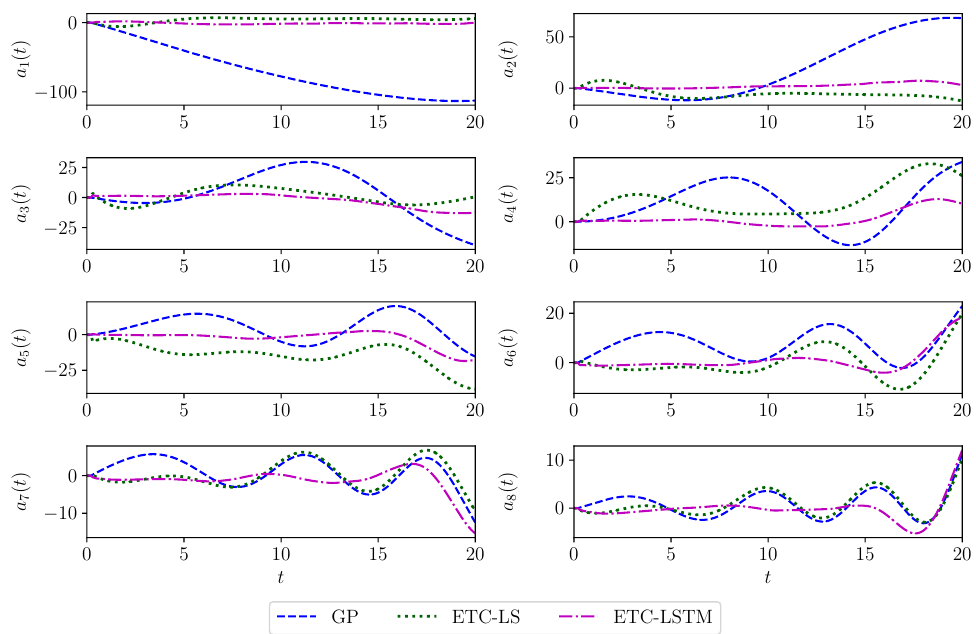
Figure 10. Evolution of the error with respect to true vorticity modal coefficients at Re = 1000 with γ =